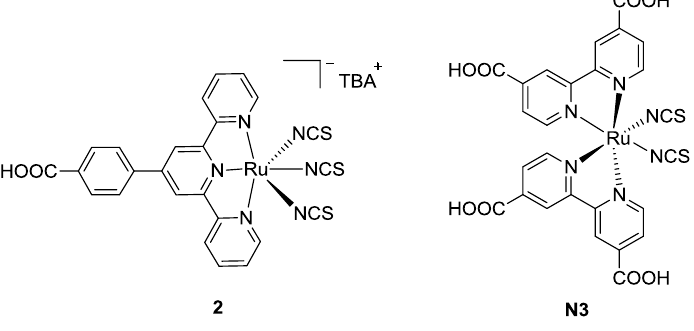
Figure 4. Structure proposed by Wang et al. and N3 dye [71].